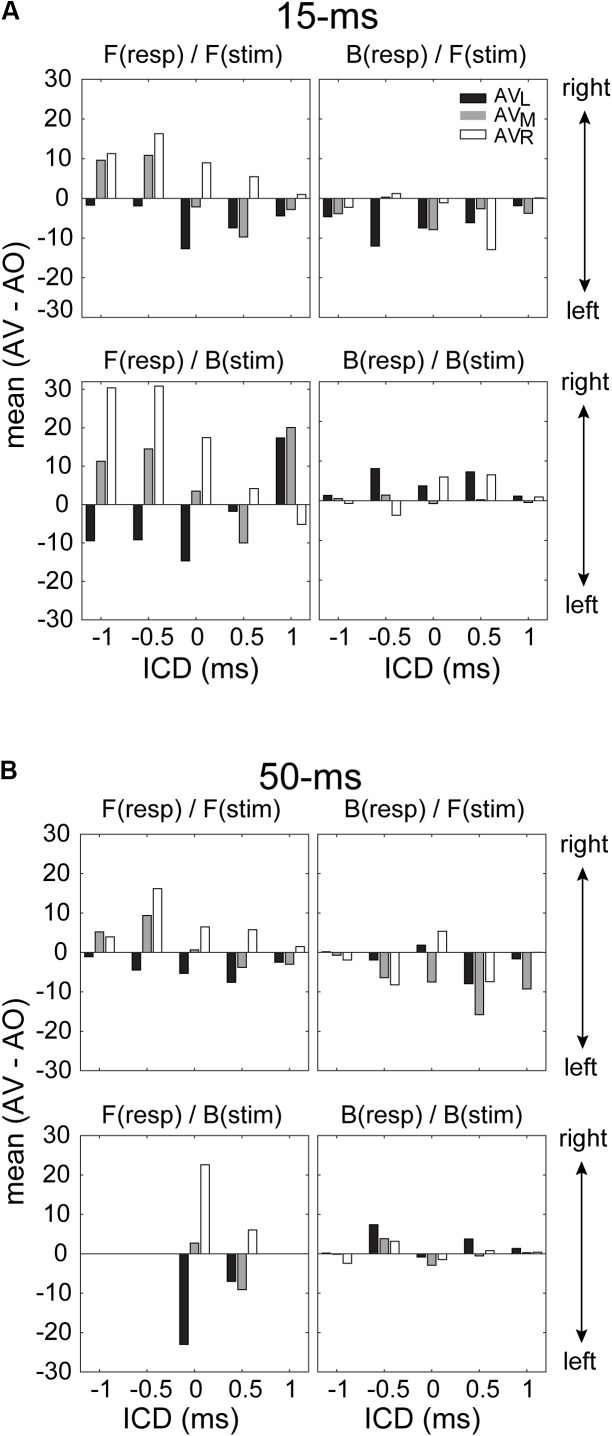
Magnitude of the lateral shift in stereo localization after visual stimulation for 15-ms (A) and 50-ms conditions (B). The lateral shift was calculated as the difference between the means of the GMM functions for AV and AO responses shown in Figures 6, 7. For the back responses, we remapped them to the angle range between –90° and 90° as those in front. For all conditions, negative and positive changes in the mean indicate leftward and rightward visual biases, respectively. The results for F(resp)/F(stim) at the 50-ms condition are in complete due to a lack of responses at some ICDs.